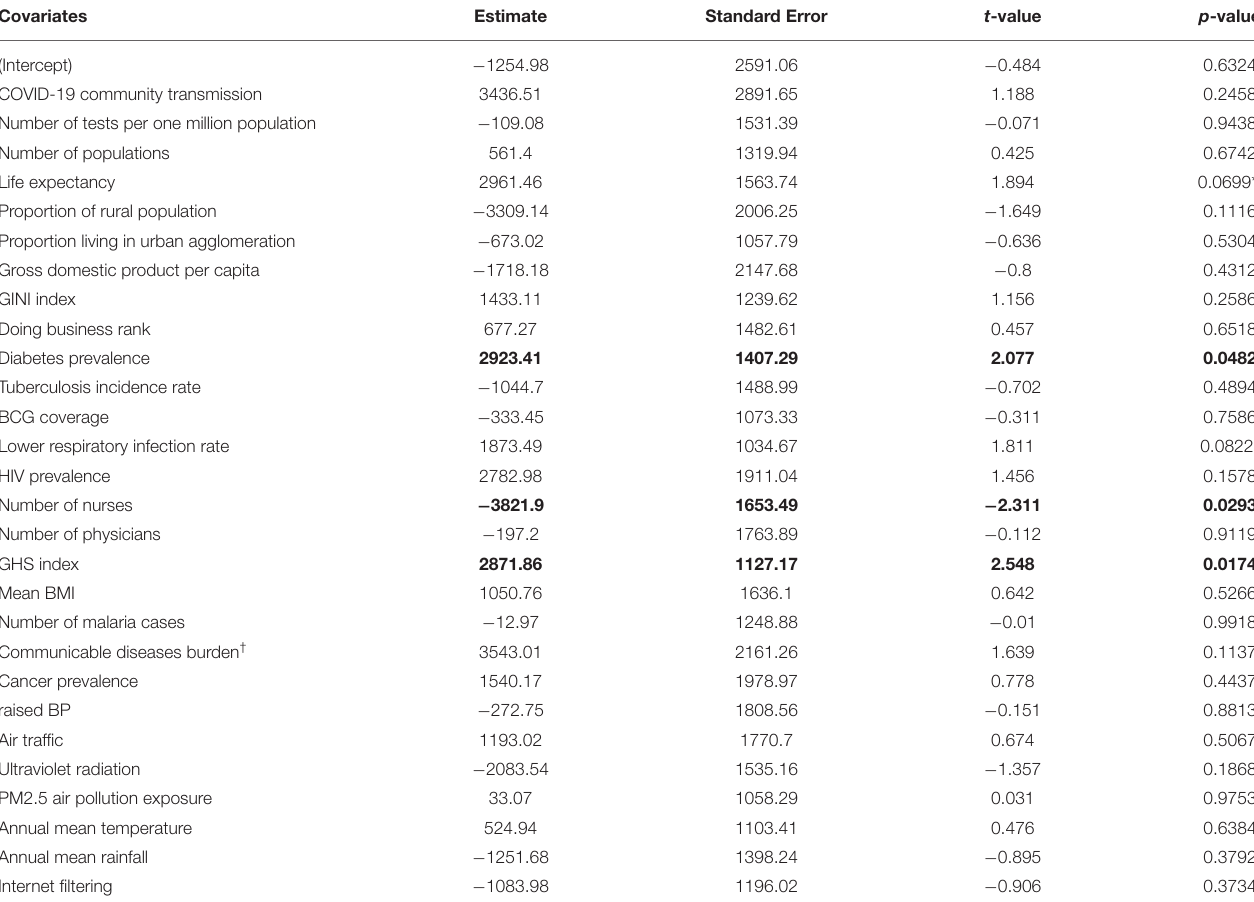
TABLE 3 | The multiple regression analysis outputs using COVID-19 deaths per one million populations as a dependent variable.